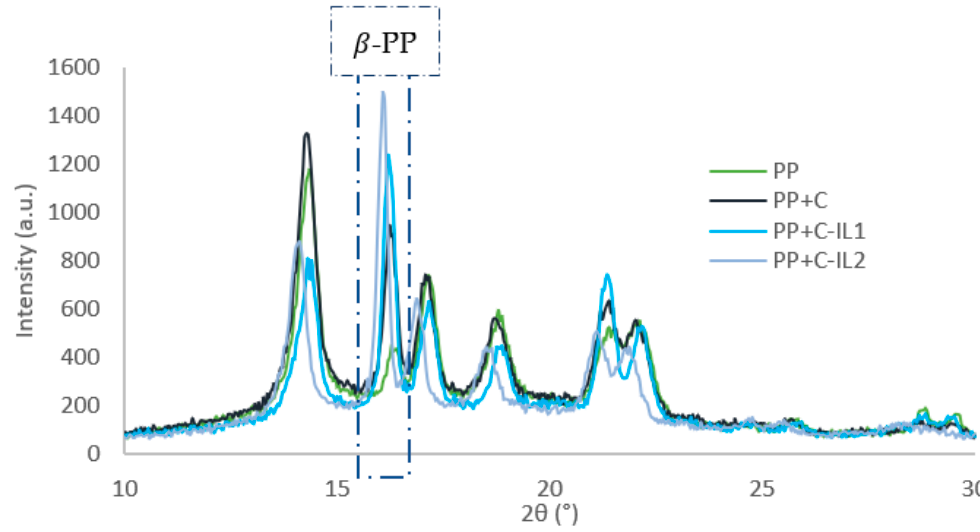
Figure 9. XRD patterns for polypropylene matrix and nanocomposite materials.